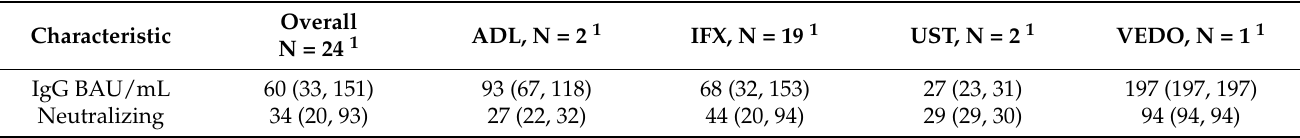
Table 4. Serological response among patients who had received only one dose of either the BNT162b2 or ChAdOx1 nCoV-19